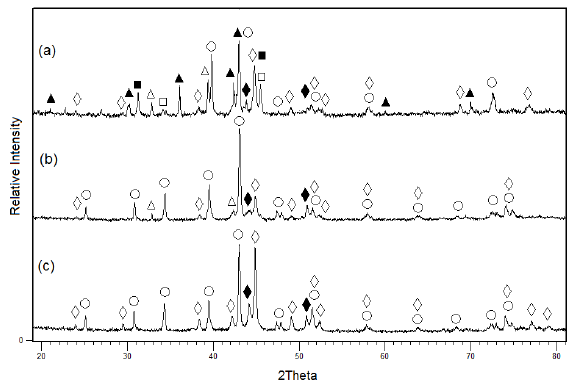
Figure 4: XRD analysis of products with compositions of a) Sample D, b) Sample E, c) Sample F ( ∘ Mo 2 NiB 2 , ♦ τ -Ni 20.5 Al 2.5 B 6 , (cid:7) Υ ′